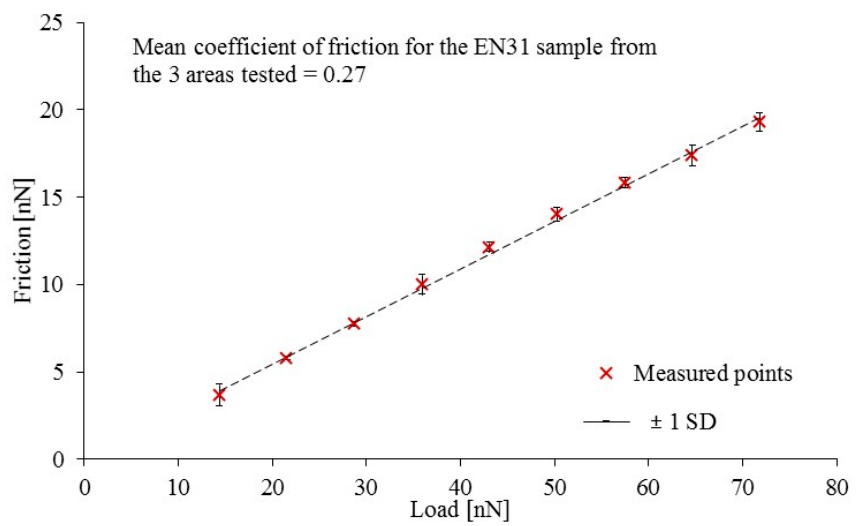
Figure 1. Measured frictional data from three areas scanned on the EN31 steel sample .